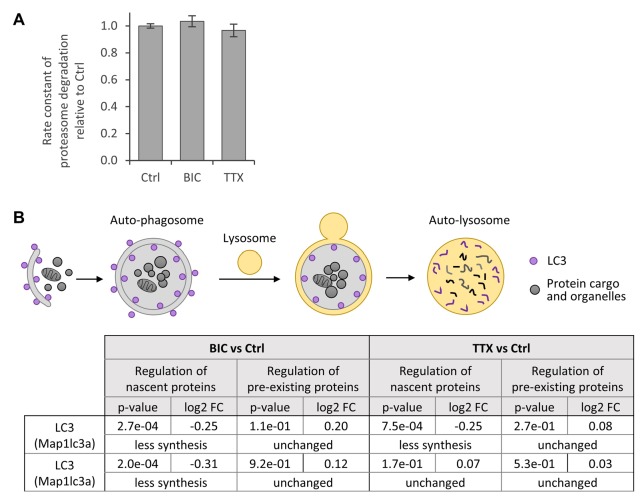
Autophagy and proteasomal degradation.(A) Proteasome activity during homeostatic scaling. Proteasome activity was measured in the lysates of primary hippocampal cultures that were treated with BIC or TTX for 7 days as well as in the lysates of untreated controls. The bar diagram represents the rate constant of proteasomal degradation and the error bars indicate the SEM. No difference in proteasome activity was observed (unpaired t-test; N = 6 biological replicates). (B) Changes in autophagy during homeostatic scaling. The degradation rate of microtubule-associated protein 1 light chain 3 (LC3) serves as marker for ongoing autophagy (Tanida et al., 2005). LC3-phospholipid conjugates are localized to the membrane of autophagosomes. LC3 inside the autophagosomes is degraded during autophagy together with the protein cargo. No change in LC3 degradation was observed during BIC or TTX treatment (N = 3 biological replicates).